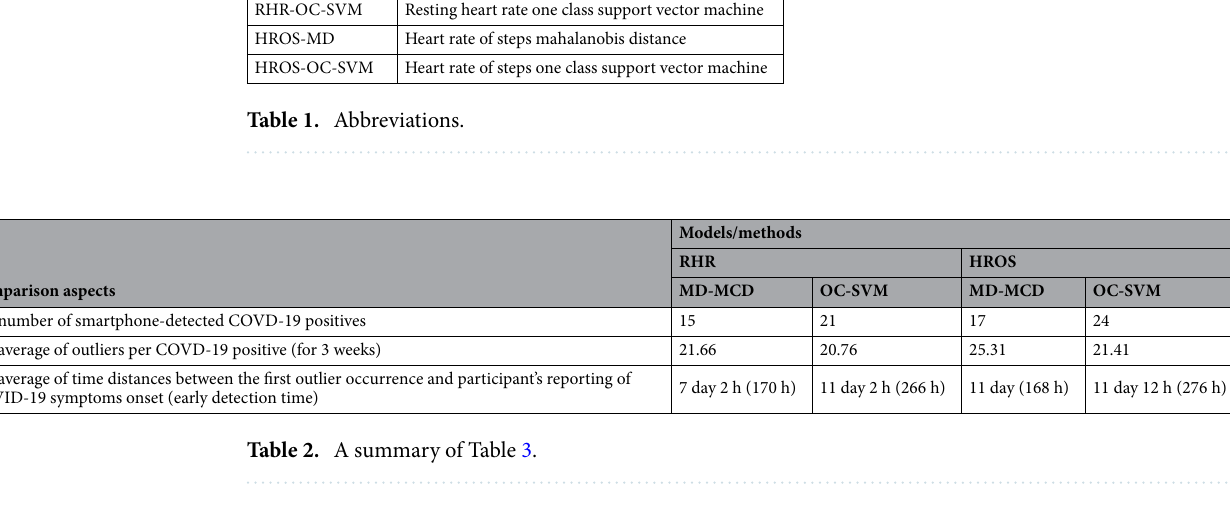
Table 3 in three aspects: the number of participants from which methods found outliers, the average number of outliers per participant, and the average time distance from the first time point of outlier occurrence to the time point for participants to report COVID-19 symptoms onset. First, the results of applying the RHR model to MD-MCD and OC-SVM methods are as follows: MD-MCD using RHR model (RHR-MD) in Mishara et al. 1 detects outliers from 15 participants out of 32 COVID-19 positive participants, excluding three error cases, and the average of the detected outliers per participant was 21.66%. OC-SVM using the RHR model (RHR-OC-SVM) detects outliers from 21 participants and finds outliers from 6 more participants (AYWIEKR, A4E0D03, ATHKM6V, AQC0L71, AJMQUVV, AFPB8J2) than Mishara et al. 1 . The number of outliers found by RHR-OC-SVM averages 20.76 per patient for the same participants. It is noteworthy that OC-SVM detects outliers from more patients than MD-MCD, but the average number of outliers found for 29 patients is about 0.9 less than MD-MCD. The time differences between the participant’s symptom (occurrence) reporting date and the first outlier occurrence are 7 days 2 h for MD-MCD and 11 days